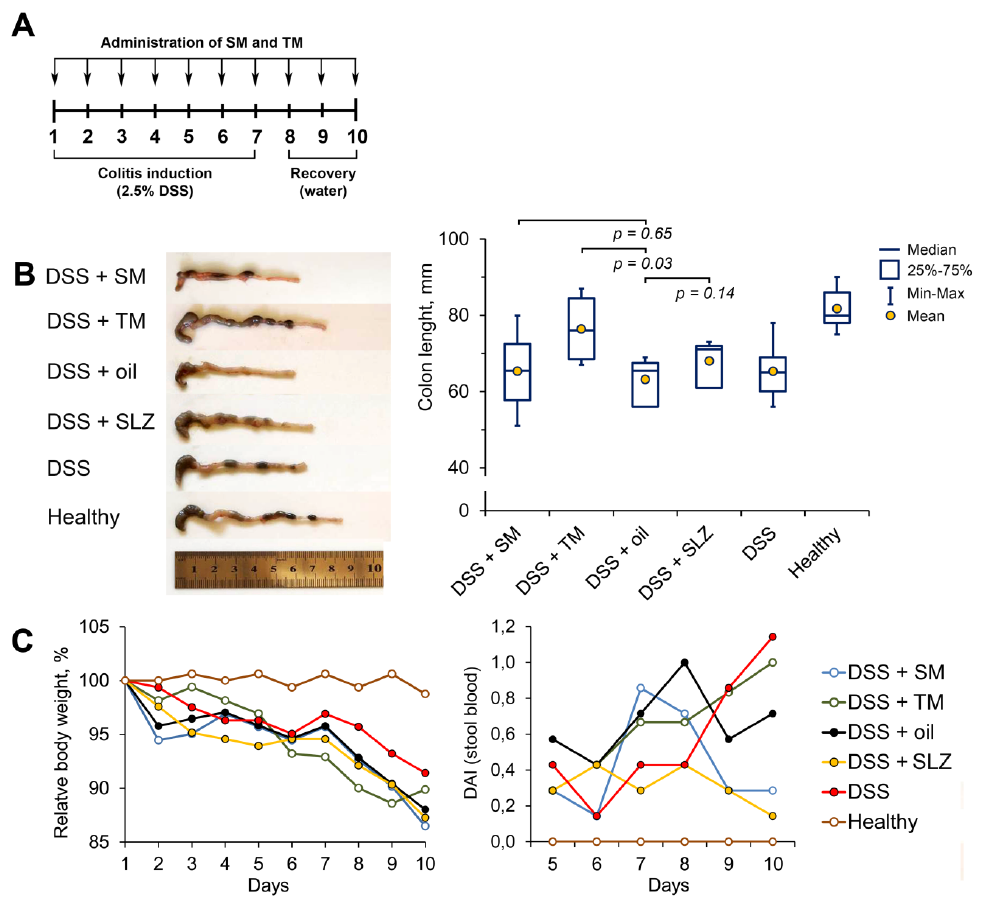
Figure 3. TM displayed pronounced anti-colitic activity. ( A ) The experimental scheme. Colitis was induced in C57Bl / 6 mice by the administration of 2.5% dextran sulfate sodium (DSS) in drinking water for 7 days. SM and TM (5 mg / kg) in sesame oil were administered via the gastric gavage simultaneously with DSS and within 3 days after the withdrawal of DSS (10 days in total). Sulfasalazine (SLZ; 100 mg/kg) was used as a reference drug. ( B ) TM suppressed the colon shortening. Colon length was measured between the ileo–cecal junction and the proximal rectum. ( C ) The relative body weight (% of initial body weight) and disease activity index (DAI) showing the level of blood in the stool of the mice. The data are presented as the means ± SD ( n = 7 per group).